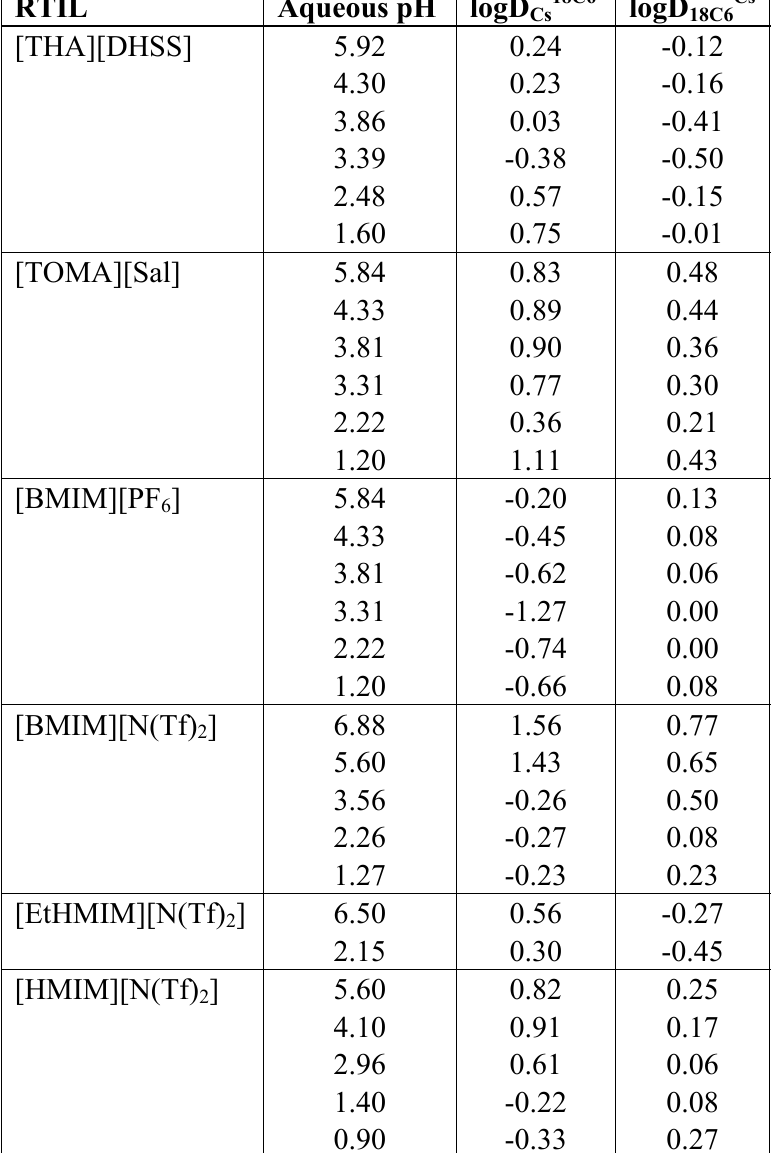
= 0.5 mL; V = 5.0 o w